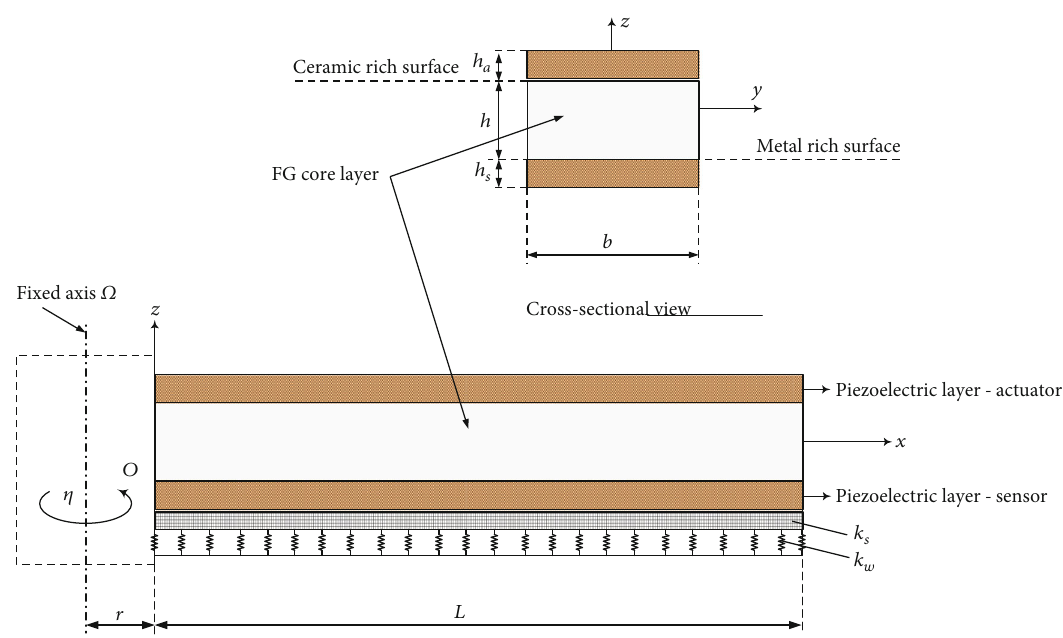
Figure 1: The representation of the rotating piezoelectric FG beam resting on Pasternak ’ s elastic